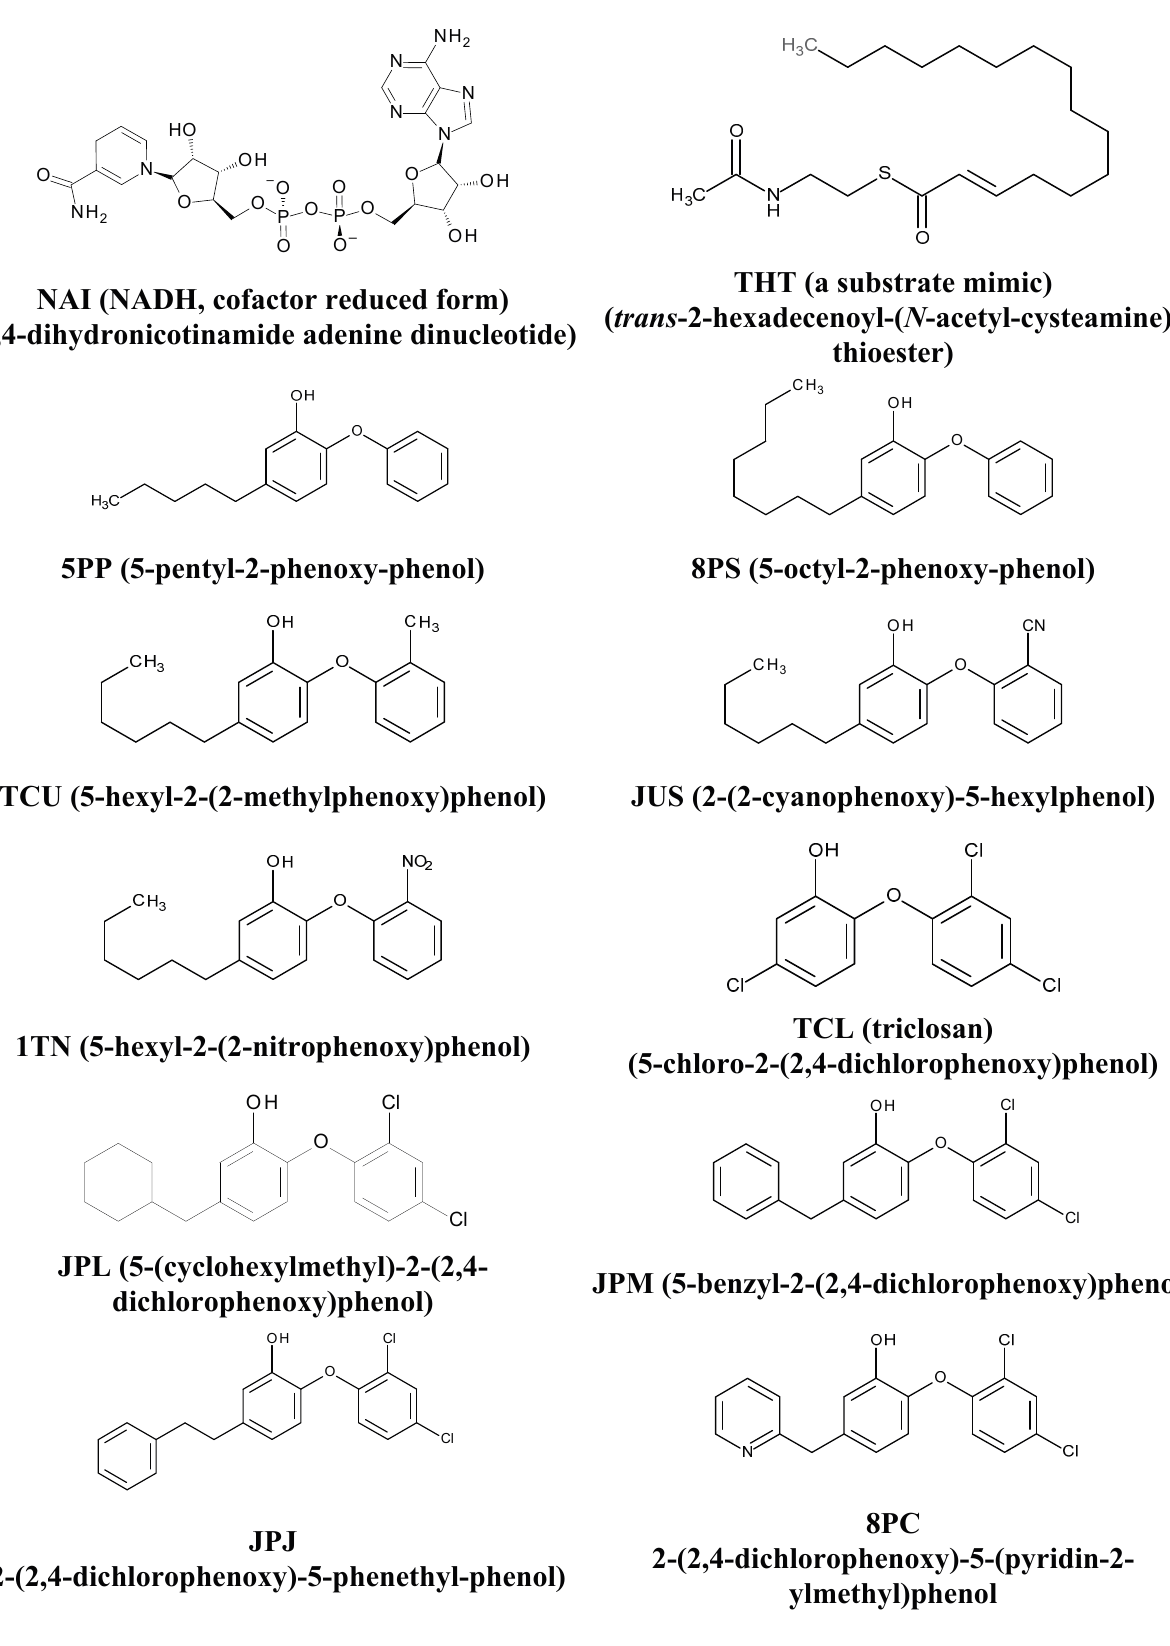
Figure 1. 2D chemical structures of NAI (NADH, cofactor reduced form), THT (a substrate mimic), and diphenyl ethers